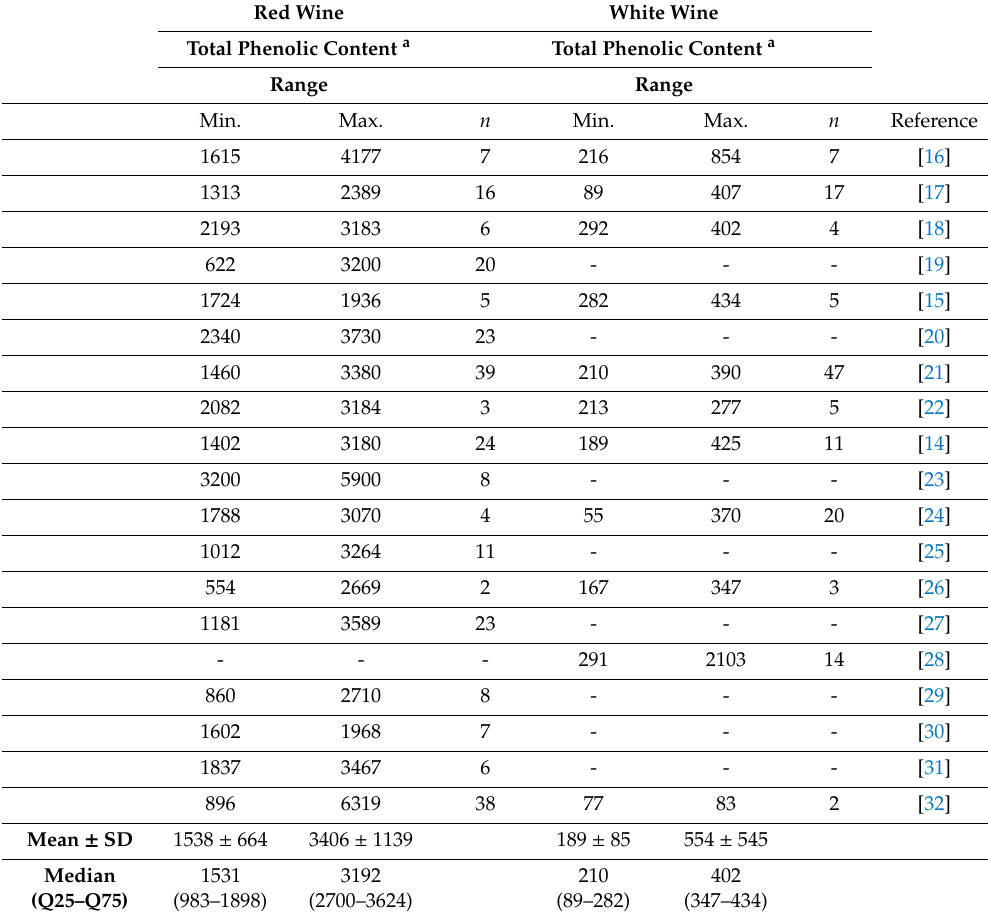
Table 2. Range of total phenolic content in red and white wines in a representative set of